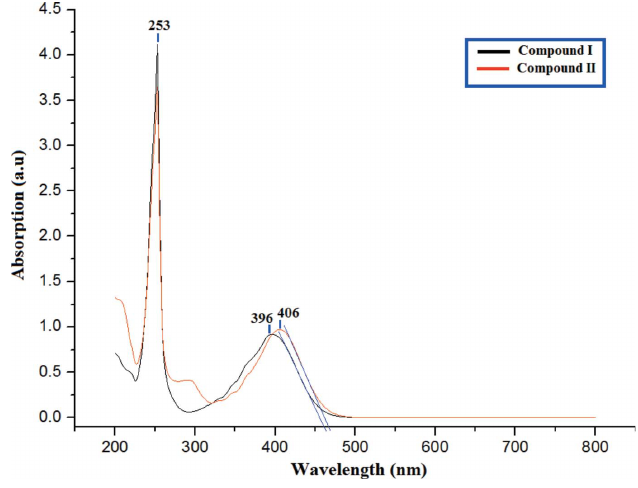
Figure 4 UV–Vis absorption spectra for compounds (I) and (II).